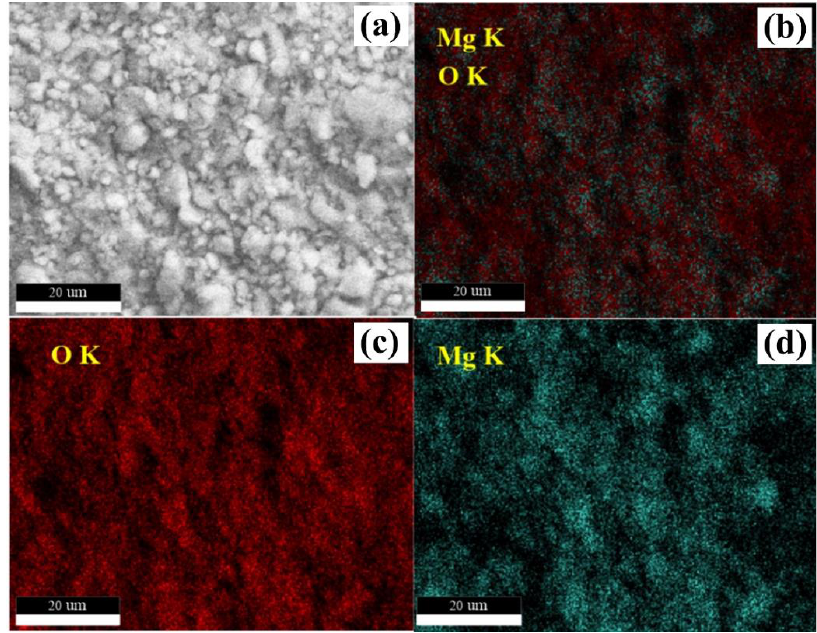
Figure 4. EDS mapping of MgO NBs. ( a ) SEM micrograph of MgO NBs, ( b ) elemental distribution of Mg and O, ( c ) distribution of O elements and ( d ) distribution of Mg elements.